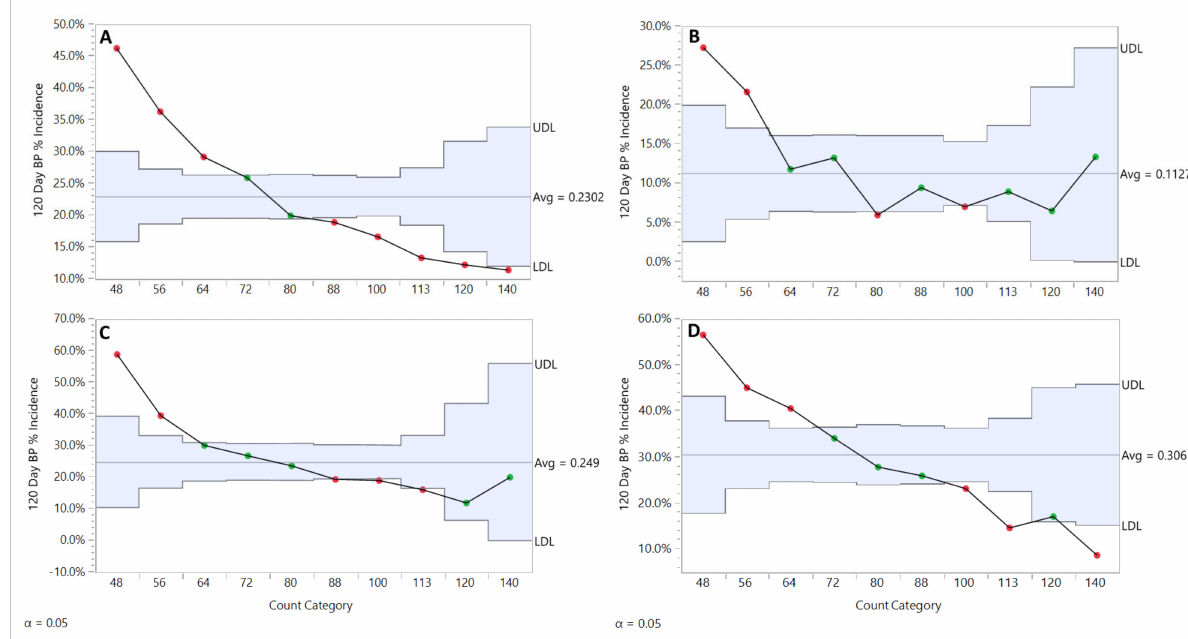
Figure 9. ‘Honeycrisp’ bitter pit incidence after 120 days storage by count size category, all rootstocks, regions, and years ( A ), and by B.9 ( B ), M.26 ( C ) and M.9 clone ( D ) all regions and all years. JMP Fit XY Platform, Analysis of Means of Proportions of the binomial dataset, alpha =